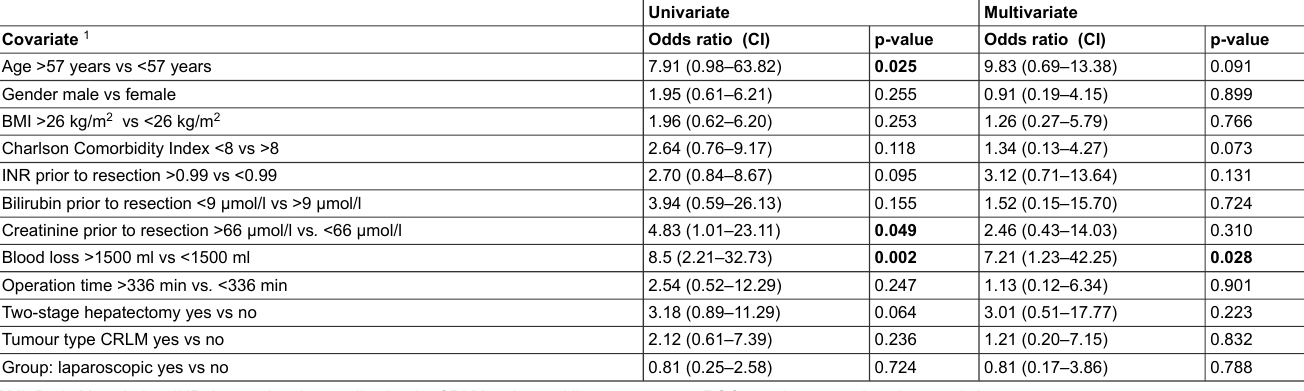
BMI: Body Mass index; INR: international normalised ratio; CRLM: colorectal liver metastases; ROC: receiver operating characteristic 1 Cutoffs for covariates were derived from logistic regression analysis using ROC curves and Youden